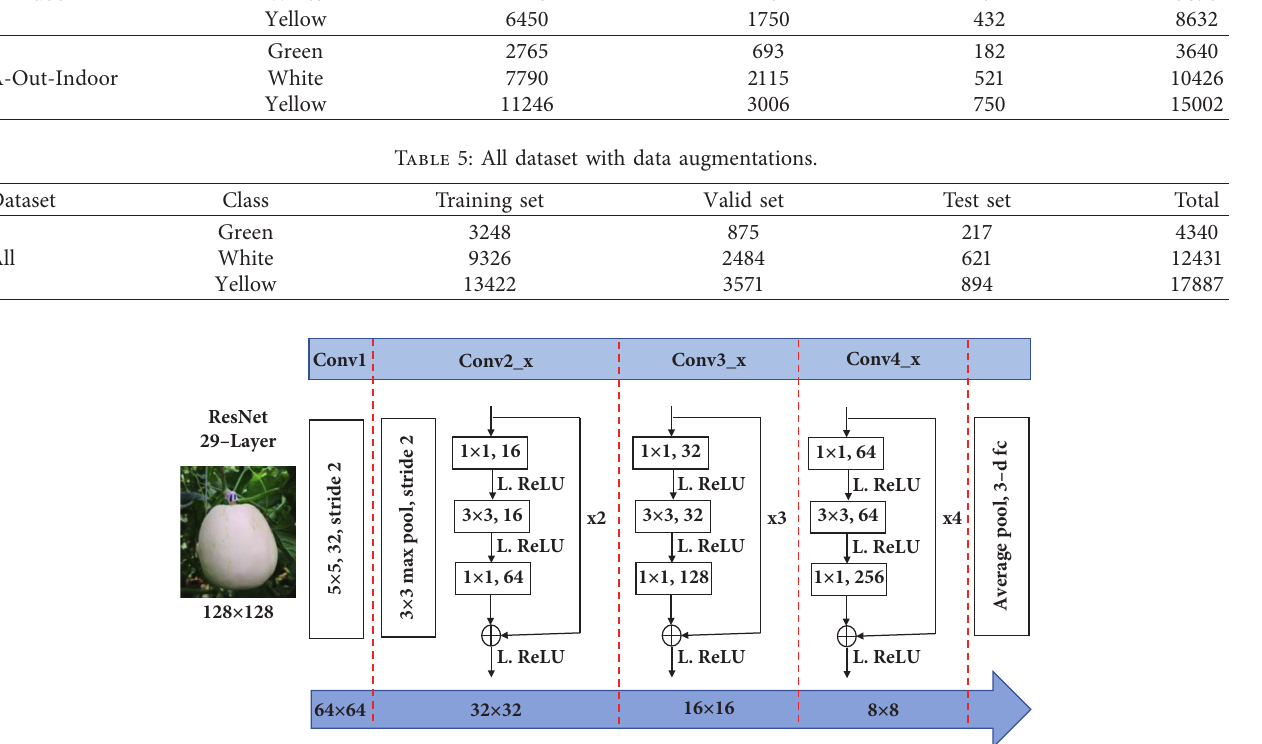
Figure 5: Modified 29-layer